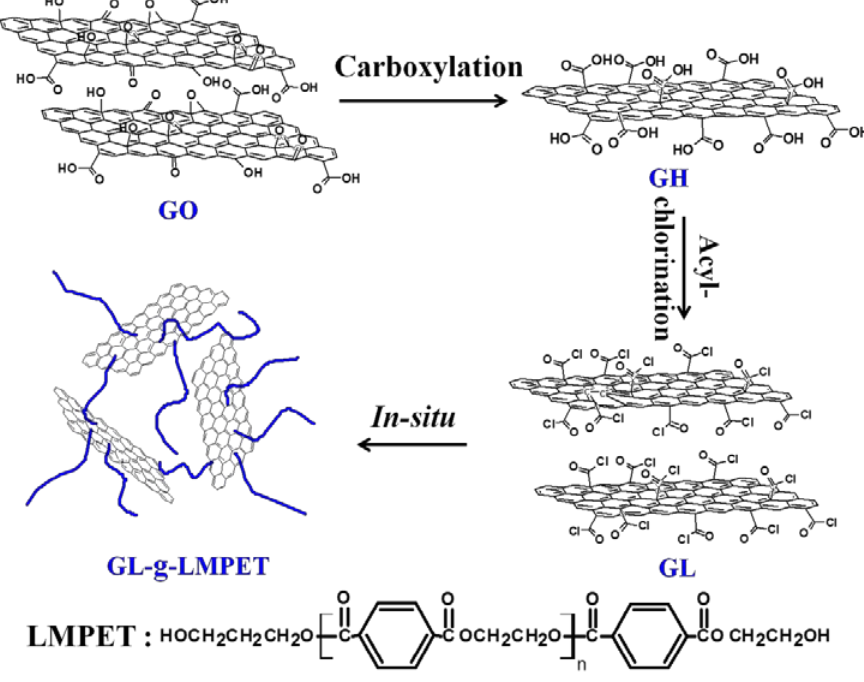
Figure 1. Schematic representation GL- g -LMPET nanoparticles formation.